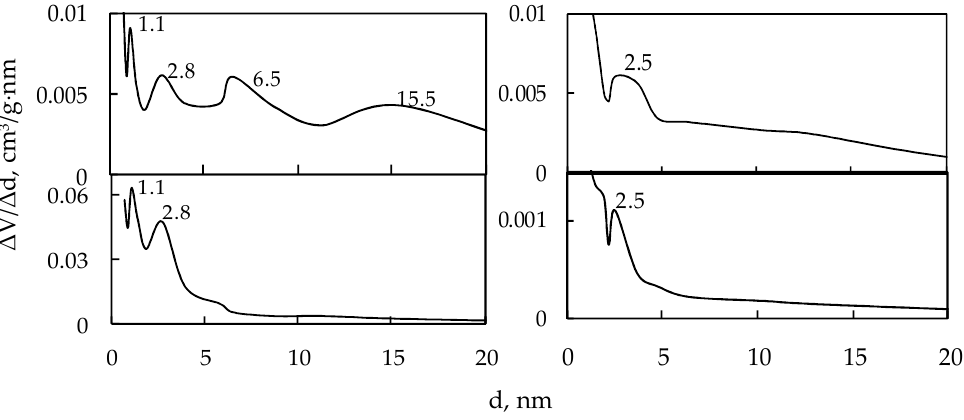
Figure 5. Pore diameter distribution curves for the manganese oxide samples under study. Table 2. Structural‐adsorption parameters for manganese oxide samples under study.